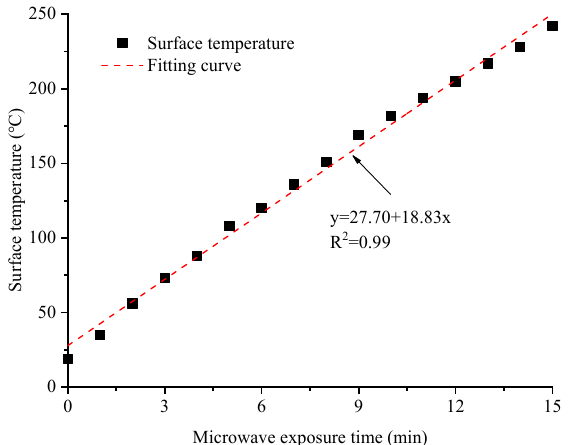
Figure 6. Relationship between the surface temperature of samples and increasing exposure to microwave irradiation.